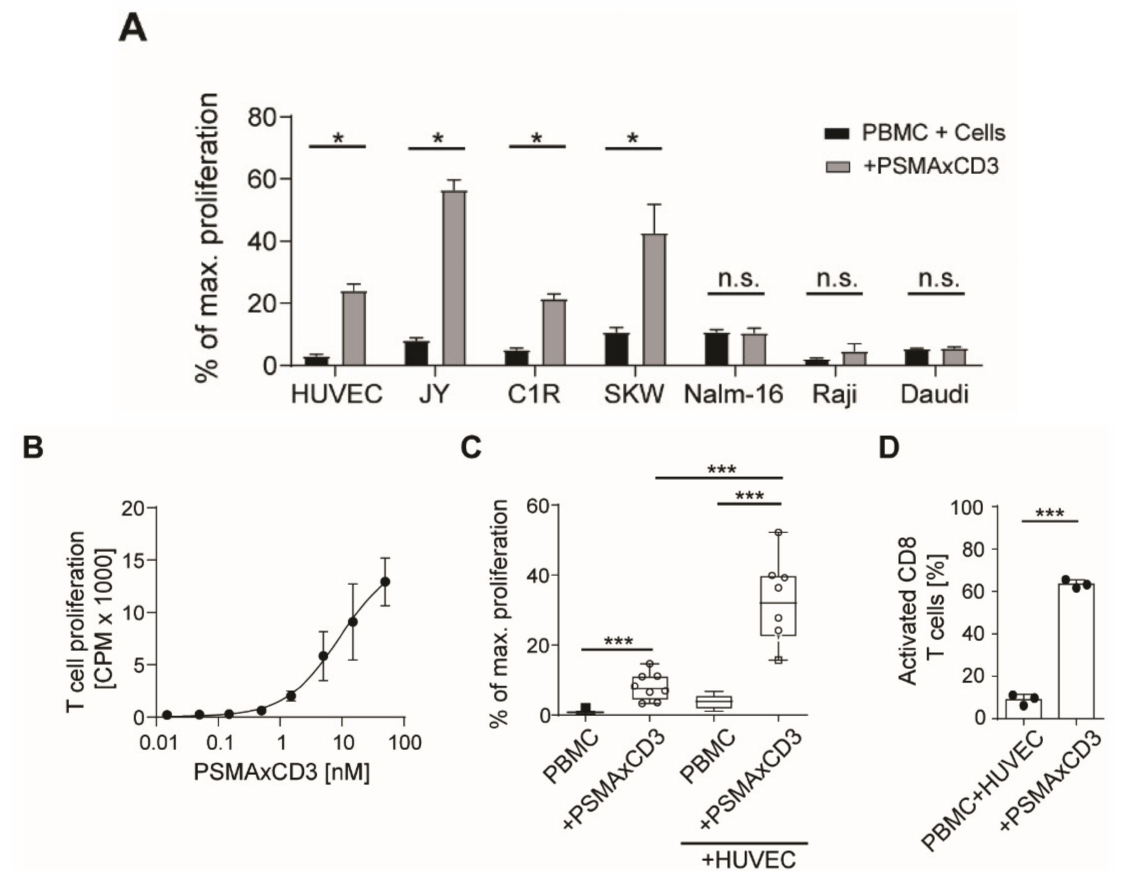
Figure 2. Increased off-target activation in the presence of stimulating bystander cells. ( A ) Off-target T cell proliferation was measured using 100,000 PBMCs, PSMAxCD3 bsAb at 5 nM and different cell lines (50,000–100,000/well) in a 3 day 3H-thymidine incorporation assay ( n = 3, mean ± SD, unpaired t -test). ( B ) T cell proliferation in a thymidine assay with 50,000 HUVEC and 100,000 PBMCs and ascending doses of PSMAxCD3 bsAb. Representative results from experiments using PBMC from n = 7 different donors. Standardization to maximum proliferation (set to 100%) as observed with PBMC + phytohemagglutinin was performed. ( C ) T cell proliferation in a thymidine assay using HUVEC, PBMC and PSMAxCD3 at 5 nM ( n = 7, boxplots with min/max whiskers, unpaired t -test). Standardization to maximum proliferation (set to 100%) as observed with PBMC + phytohemagglutinin was performed. ( D ) Flow cytometric analysis of Activation (CD69 expression) of CD8 T cells after 3 day off-target stimulation with 50,000 HUVECs and PSMAxCD3 bsAb at 5 nM ( n = 3, mean ± SD, unpaired t -test). * p < 0.05, *** p <